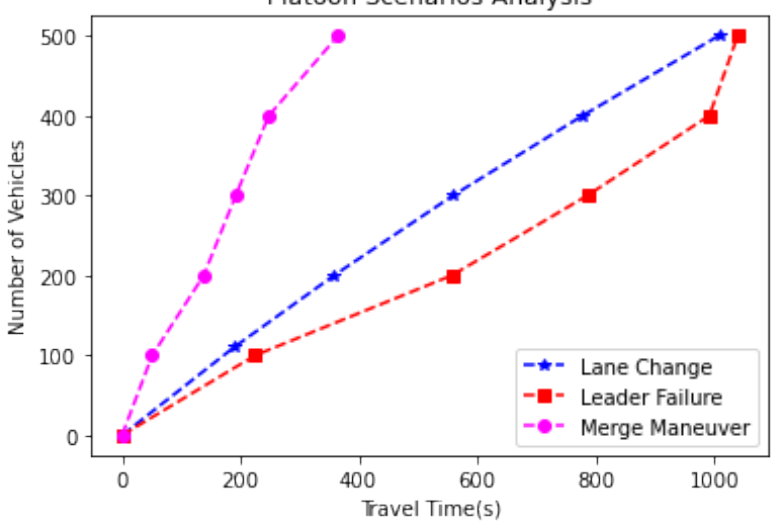
Figure 16. Number of AVs vs travel time to reach destination in different